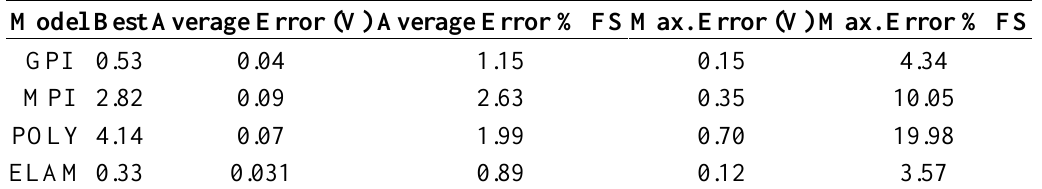
Figure 9. Models for descending curves. ( a ) GPI model with n = 4 play operators; ( b ) MPI model with third-order polynomial and n = 10 OSP operators; ( c ) POLY model with sixth-order polynomial; ( d ) ELAM model. Table 4. Average errors and maximum errors of hysteresis models for descending